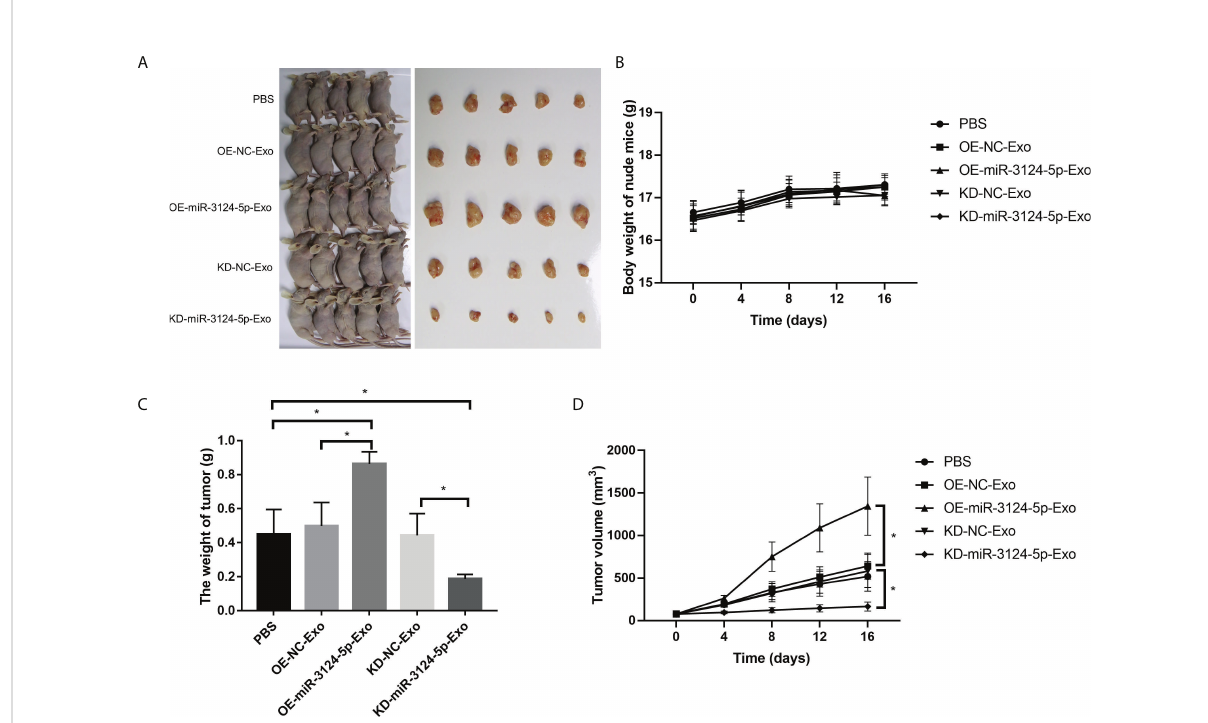
FIGURE 7 Exosomal miR-3124-5p promoted tumor growth in vivo . (A) Photographs of macroscopic tumor appearance. (B) Body weight of nude mice of different groups. (C) Tumor weight of different groups. (D) Tumor volume of different groups. * p < 0.05.